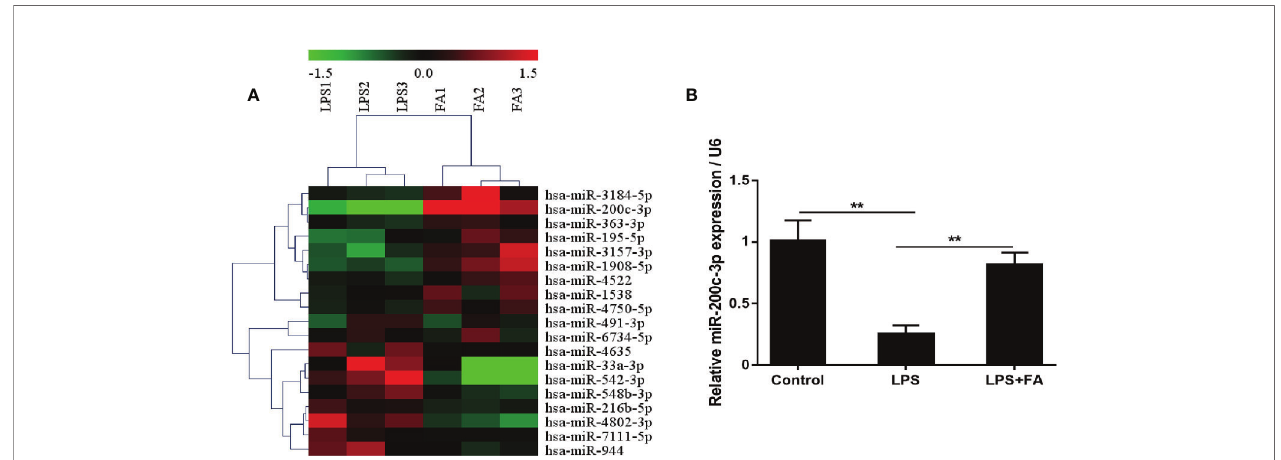
FIGURE 3 | MiR-200c-3p expression was increased by FA in LPS-induced Caco-2 cells. Cells were pretreated with FA (100 m M) for 2 h and then stimulated with LPS for 24 h. (A) Heat map evaluation of the distinguishable miRNA expression patterns among the LPS and LPS+FA group samples. Each column represents the expression pattern of one sample, and the high expression level and the low expression level are indicated by the “ red ” and “ green ” lines, respectively. (B) The expression of miR-200c-3p was measured by qRT-PCR. Data were presented as means ± SD from three independent experiments and differences between means were compared using one-way ANOVA with Tukey ’ s multiple comparisons test. ** P <